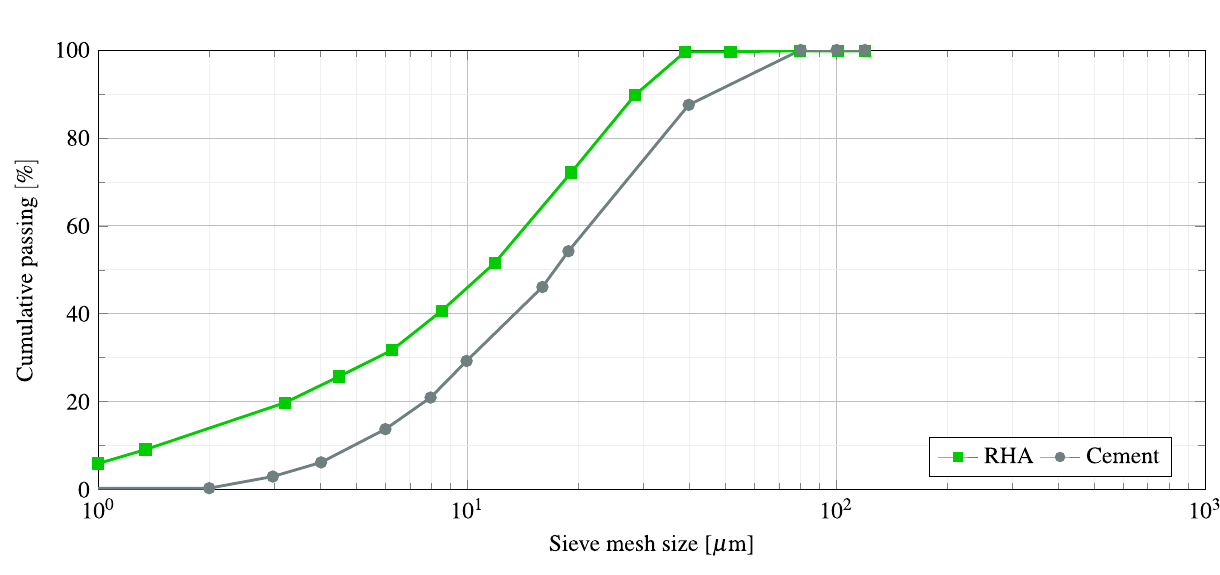
Figure 1. Particle size distribution curves of cement and